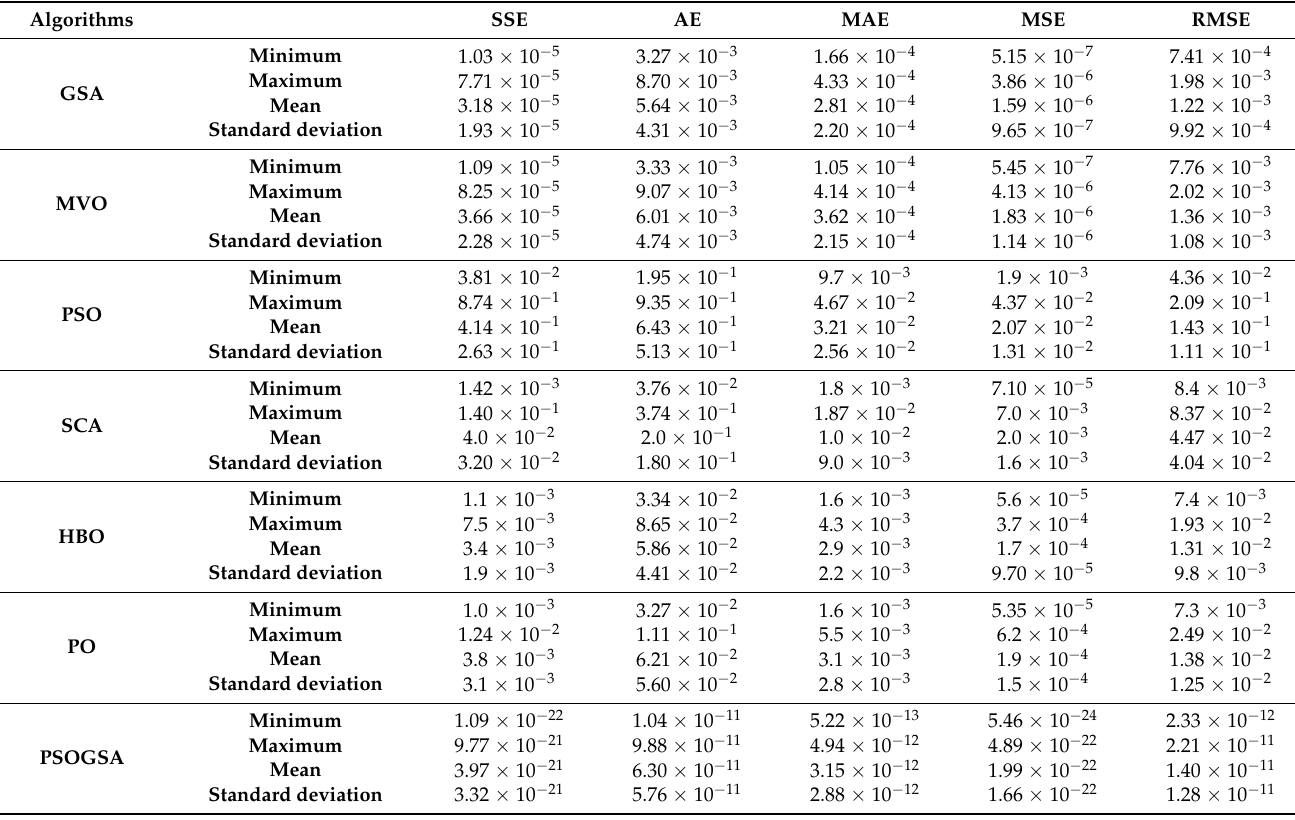
Table 17. The MTDM calculation error, mean and standard deviation for Case 2.